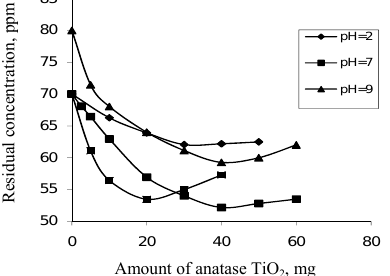
Figure 2. The effect of anatase titanium dioxide loading on residual concentration of tolonium chloride after irradiation(Time= 60 min. V=20 mL)